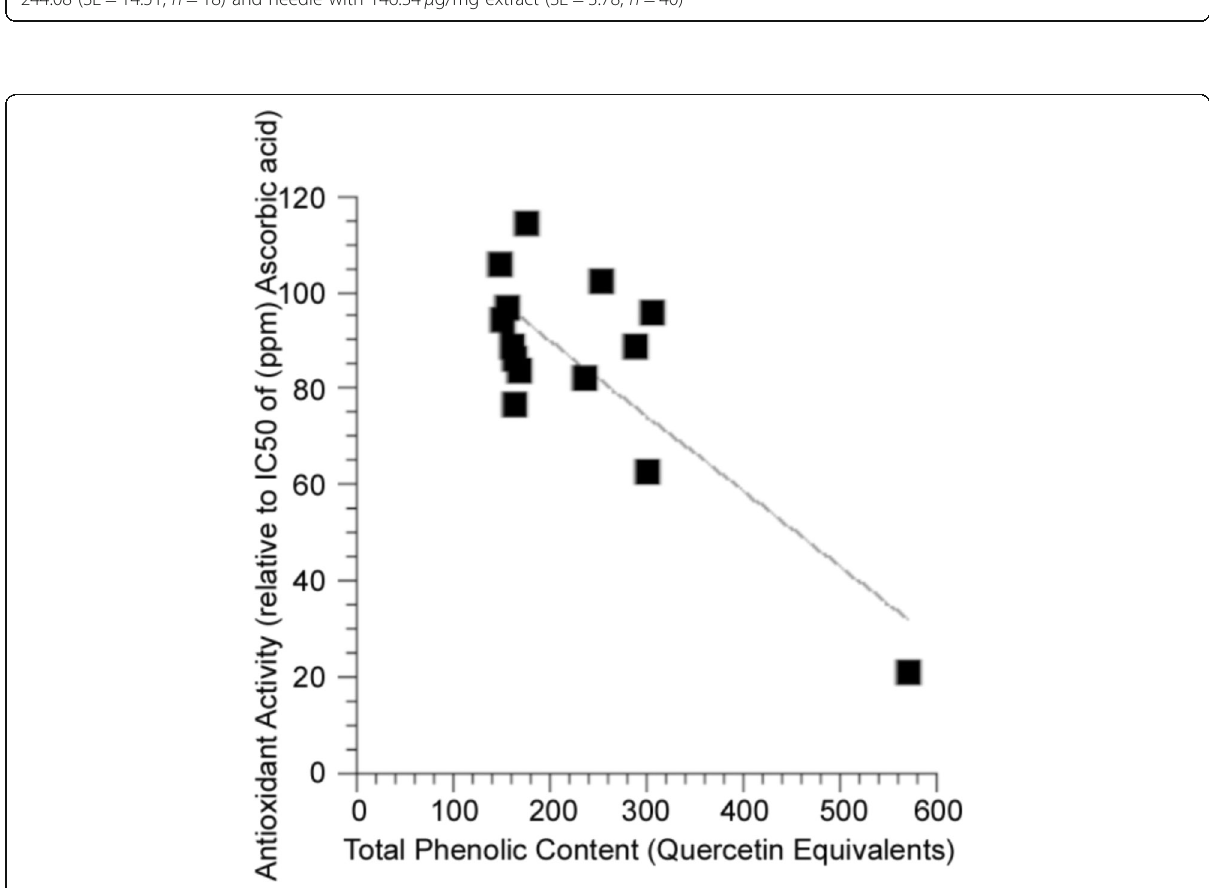
Fig. 5 Regression analysis of total phenolic content of P. mariana extracts with respect to antioxidant activity. Total phenolic content is measured in terms of quercetin equivalents and antioxidant activity is calculated with respect to the ascorbic acid standard curve. The trend shows that as phenolic content increases the amount of plant extract (EC 50 in ppm) necessary to reach the IC 50 of ascorbic acid decreases and therefore, antioxidant activity increases with increasing phenolic content ( r 2 =0.63, p ≤ 0.05, n =14). The data passed a normality test in order to ensure that it follows a normal